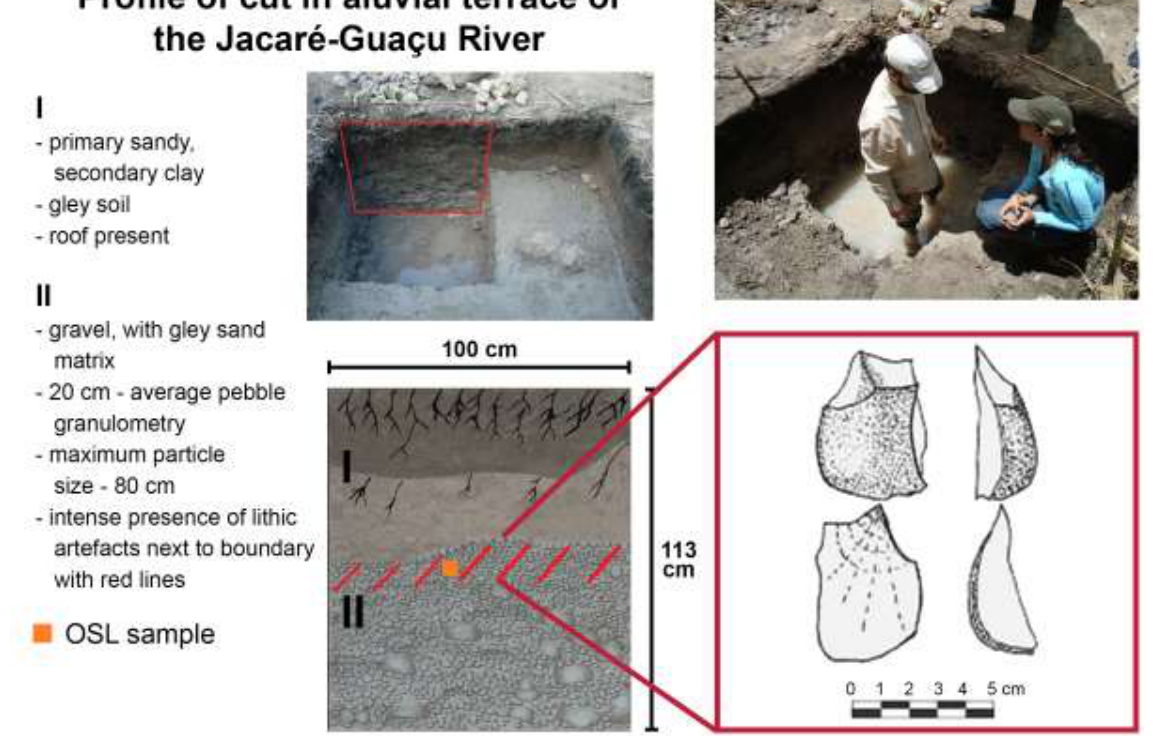
Figure 7. Profile of a lateral cut in the Excavation Unit 01 of 2010 (UE01-2010), and location of OSL sample with a date of 14500+-3000 years BP (FATEC). Source: adapted from Santos (2011); Cheliz (2011;